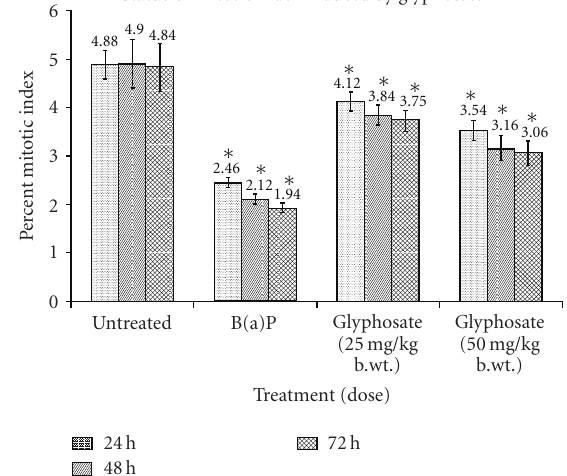
Figure 3: Cytotoxic e ff ects glyphosate in Swiss albino mice indicated by decrease in mitotic index (MI) at 24, 48, and 72 hours of sampling time. Values are expressed as mean ± SE of 5 animals. ∗ Represent significant decrease over untreated control group at their respective sampling time. Data are significant as P <